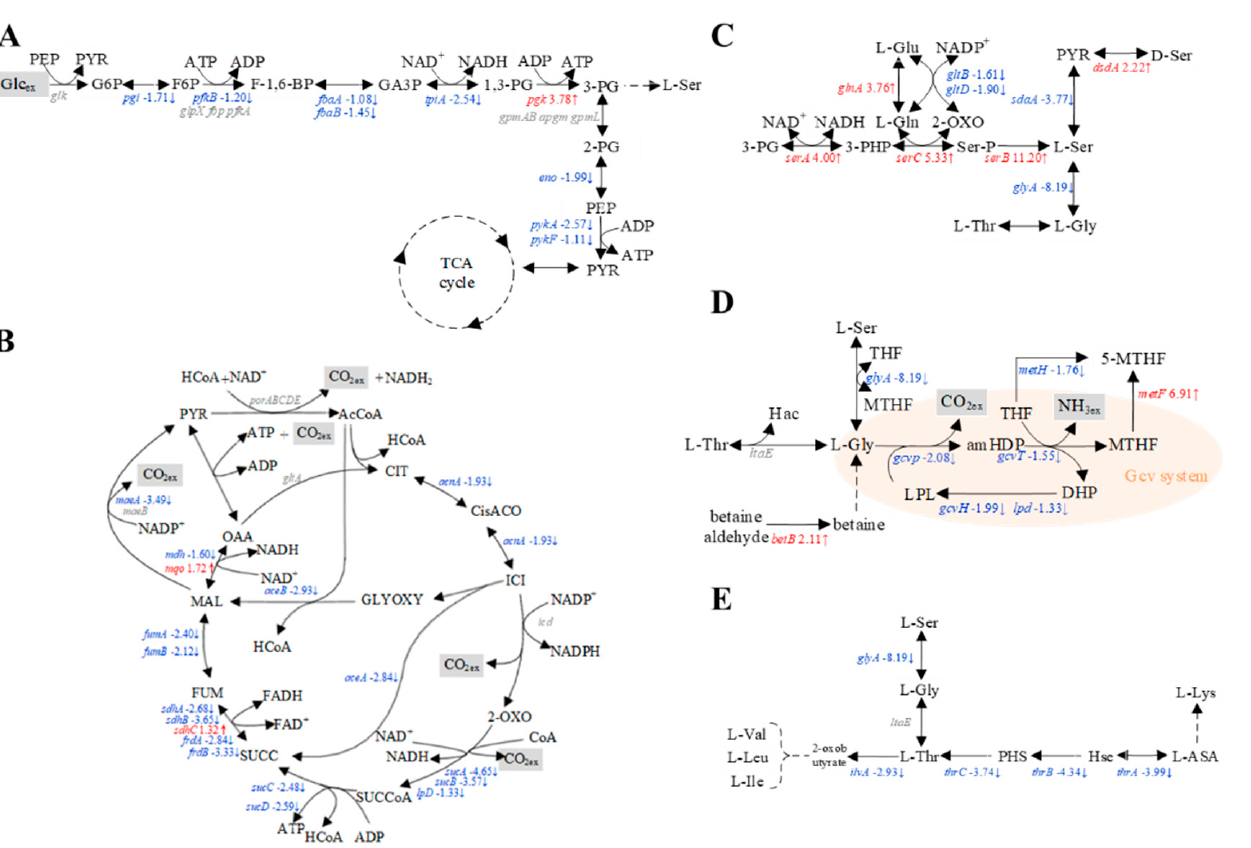
Figure 6. Gene expression levels related to the glycolysis, TCA cycle, and amino acid pathways related to L-Ser synthesis. ( A ) Glycolysis, ( B ) TCA cycle, ( C ) L-serine, ( D ) L-glycine, and ( E ) L-threonine biosynthesis of SSW-10/SP-09. Significant changes in the expression ratio to transcript levels are represented by color ( p -value < 0.05, and fold changes > 2.0), three independent replicates. The red color indicates a higher expression level of SSW-10/SP-09; blue color indicates a lower expression level of SSW-10/SP-09; gray color indicates no changes; gene with number indicates log2 ratio (SSW-10/SP-09/W3110).